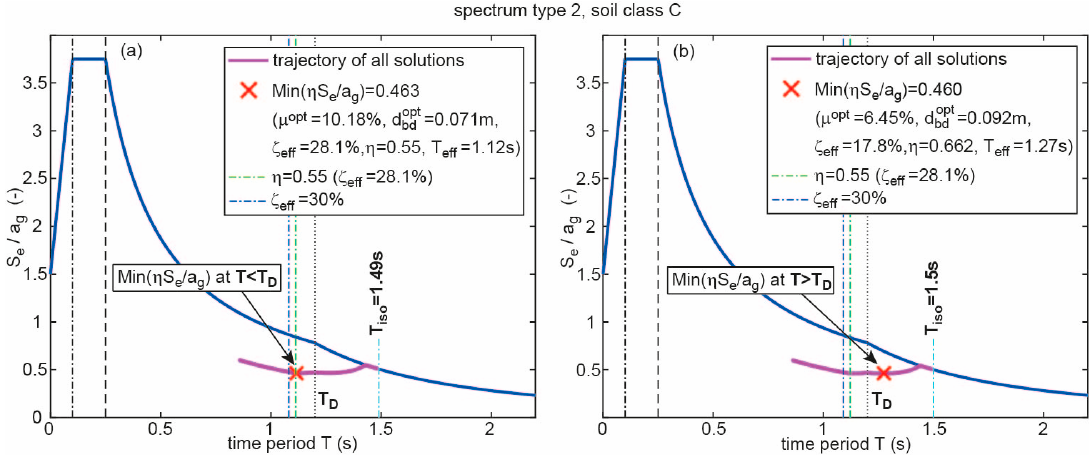
Figure 10. Optimization trajectories for ( a ) T iso = 1 s and ( b ) T iso = 2 s for spectrum type 2 with soil class C.